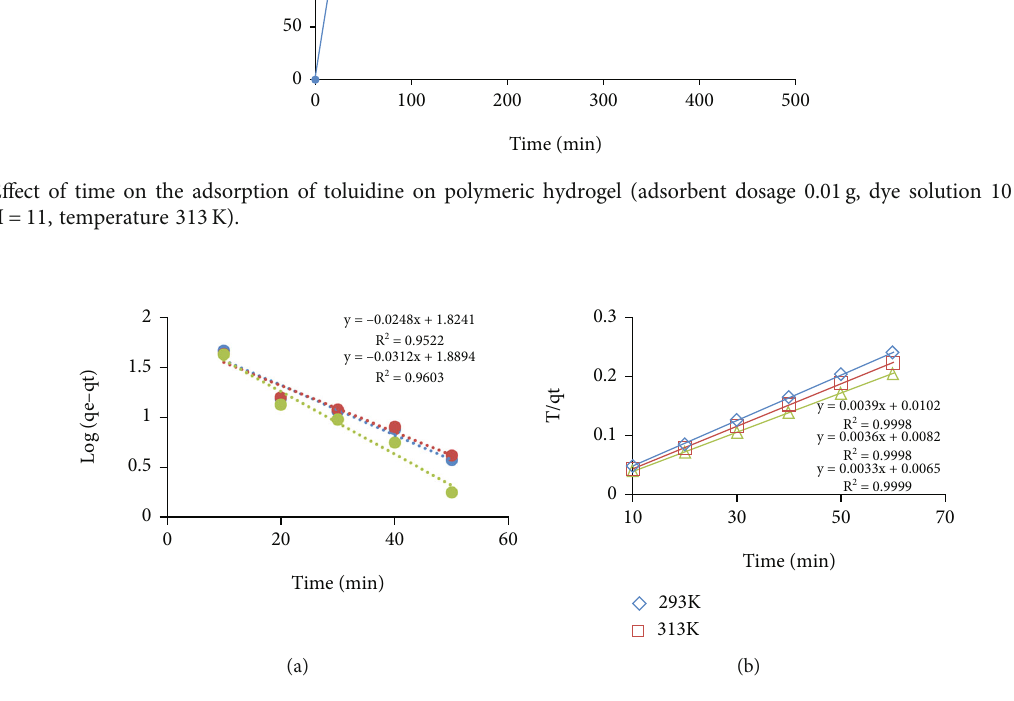
Figure 7: Kinetics of safranin adsorption on GA/AM (adsorbent 0.01, dye solution 10mL, pH 11, temp 313 K, time 60 min): (a) pseudo-1 st - order plot and (b) pseudo-2 nd -order plot.